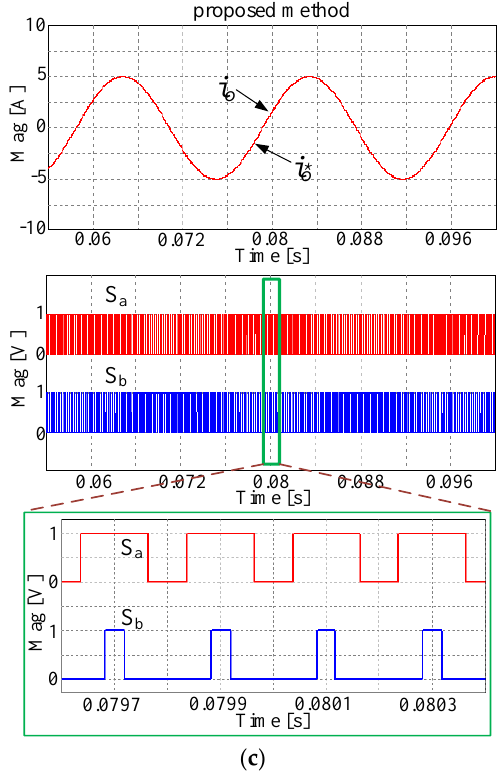
Figure 7. Simulation results of the output current ( i o ) and the reference current( i o * ) and upper switching states ( S a , S b ) with same average switching frequency. ( a ) conv-MPC ( T s = 33 μs); ( b ) the sinusoidal PWM method along with the PI controller (PIPWM) ( T sw = 200 μs); ( c ) proposed method ( T s = 200 μs).